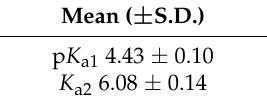
Table 1. p K a observed for Compound 1 .